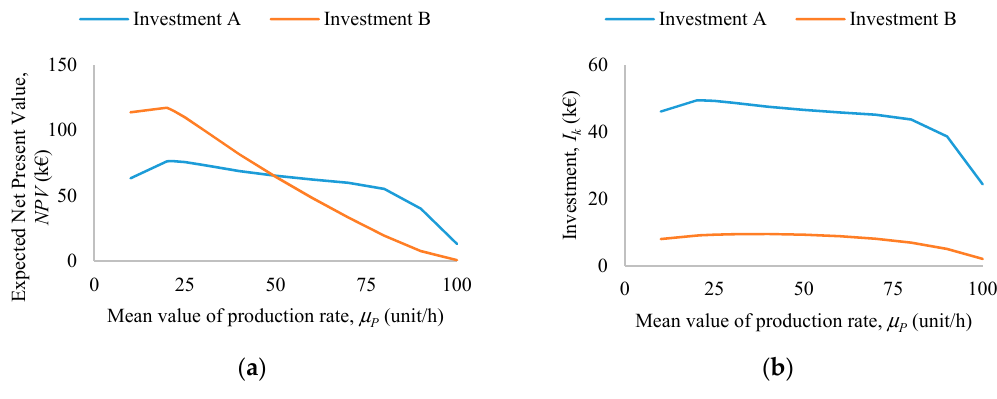
Figure 4. Effects of variation in the mean value of the production rate 𝑃 on ( a ) the expected net Figure 4. E ff ects of variation in the mean value of the production rate P on ( a ) the expected net present